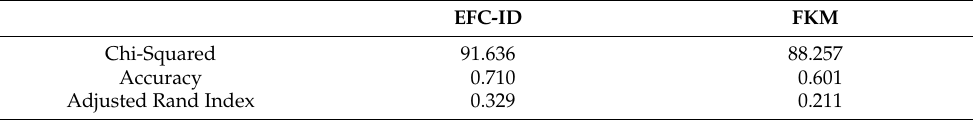
Table 9. Performance indexes obtained by EFC-ID and FKM for Multiple Myeloma